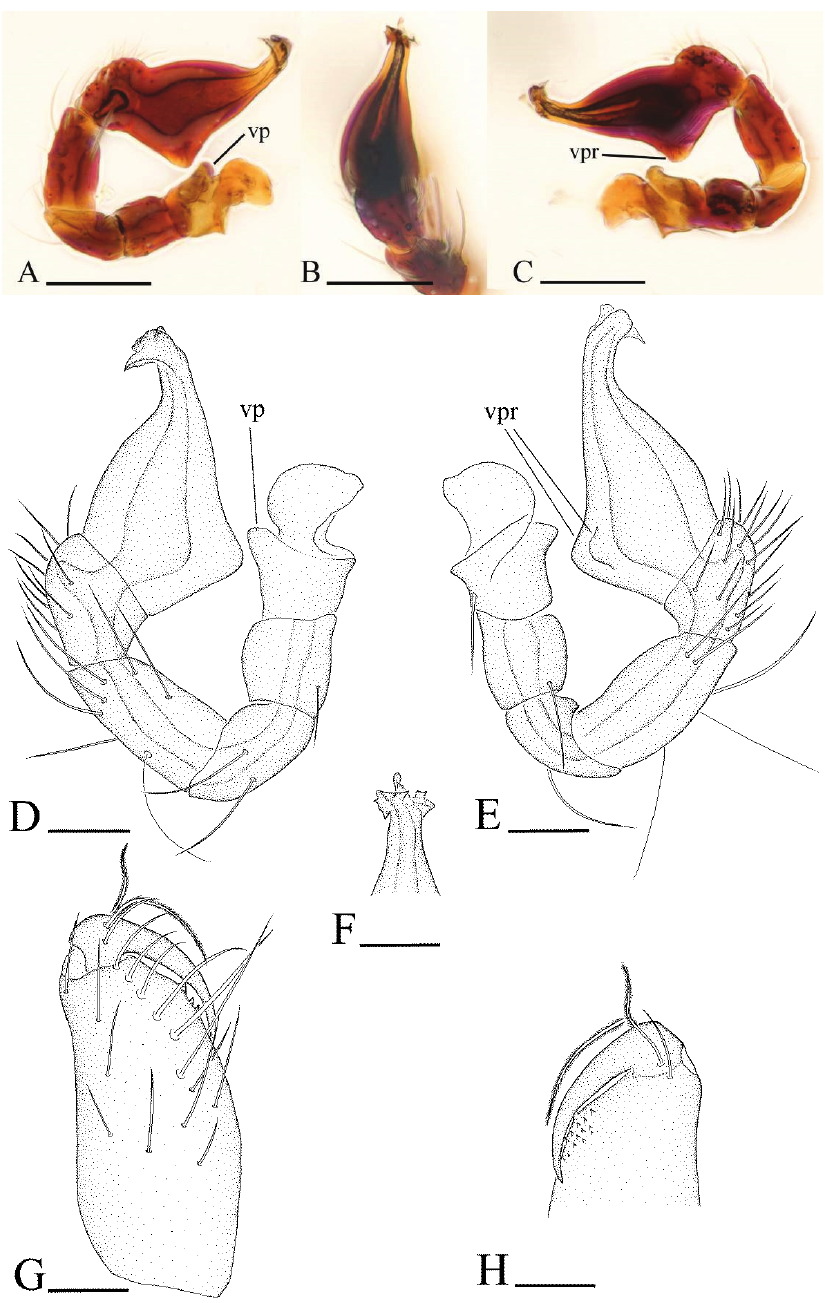
Figure 6. Ischnothyreus brunneus sp. n., male. A, D left palp, prolateral view B left palp, dorsal view C, E left palp, retrolateral view F distal part of palpal bulb, dorsal view G, H left chelicera, anterior and pos- terior views. Abbreviations: vp = ventral projection; vpr = ventral protuberance. Scale bars: A–C = 0.1 mm; D–H = 0.05